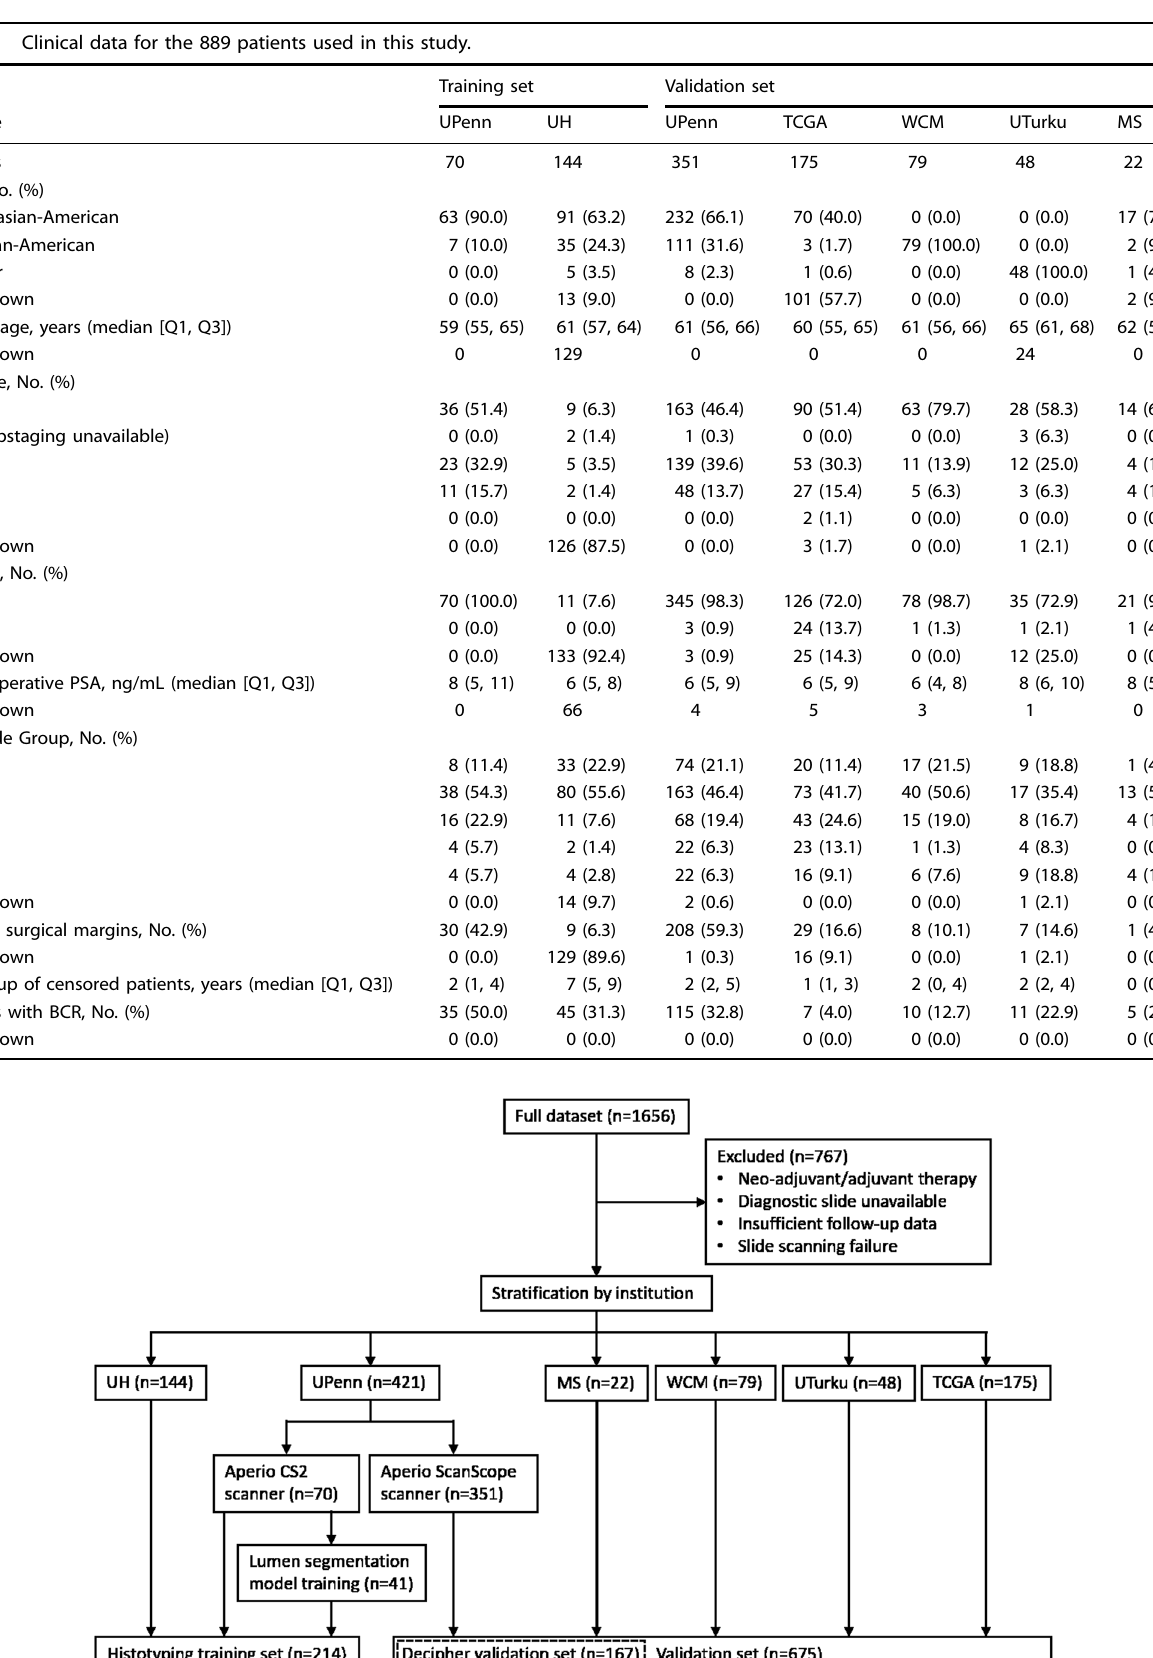
Table 3. Clinical data for the 889 patients used in this study.